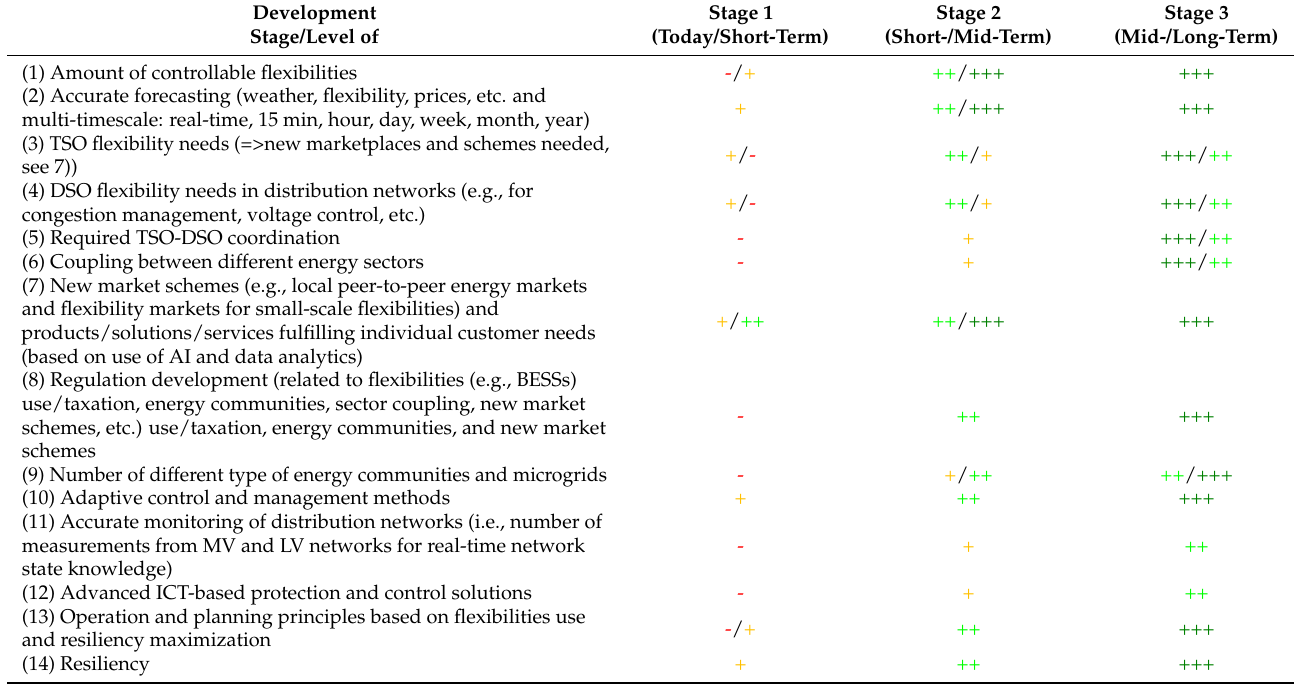
Table 1. Potential three-stage evolution path toward fully flexible and digitalized electricity distribution systems/networks. Development Stage/Level of